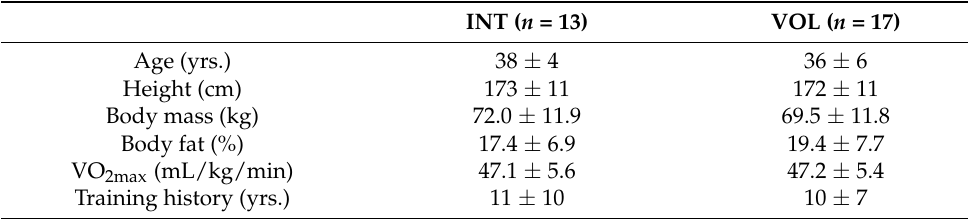
Table 1. Baseline characteristics of the participants at the beginning of the control